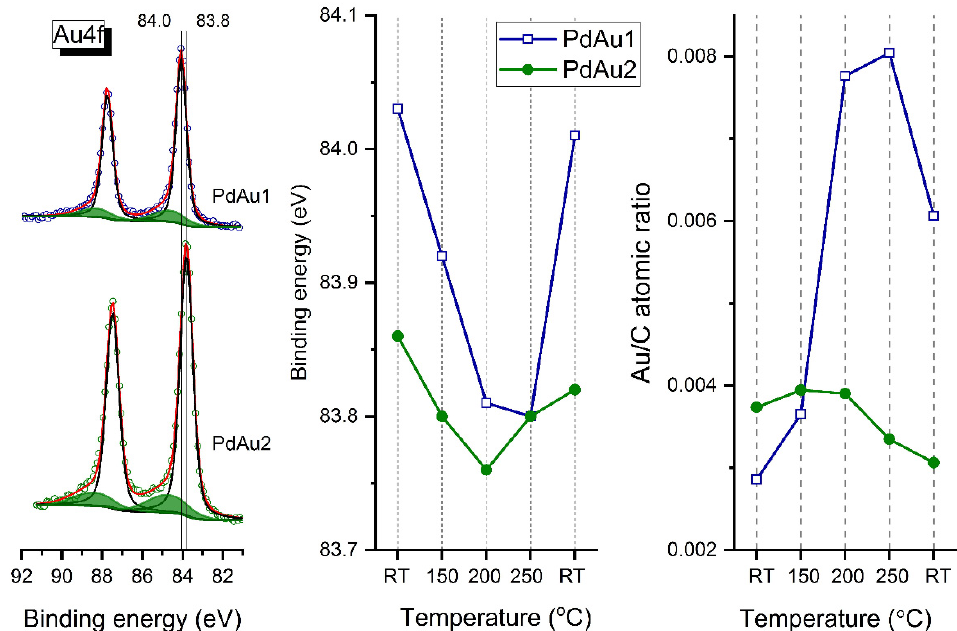
Figure 3. Au4f XP spectra for the PdAu-1 and PdAu-2 model alloy catalysts at room temperature ( left panel ) along with Au4f 7/2 BEs ( central panel ) and Au-to-carbon atomic ratios ( right panel ) determined in the in situ mode in the mixture of CO and O 2 (2:1) at a total pressure of 0.25 mbar and different temperatures. The kinetic energy of the photoelectrons was 300 eV (the depth of analysis was 1.8 nm).